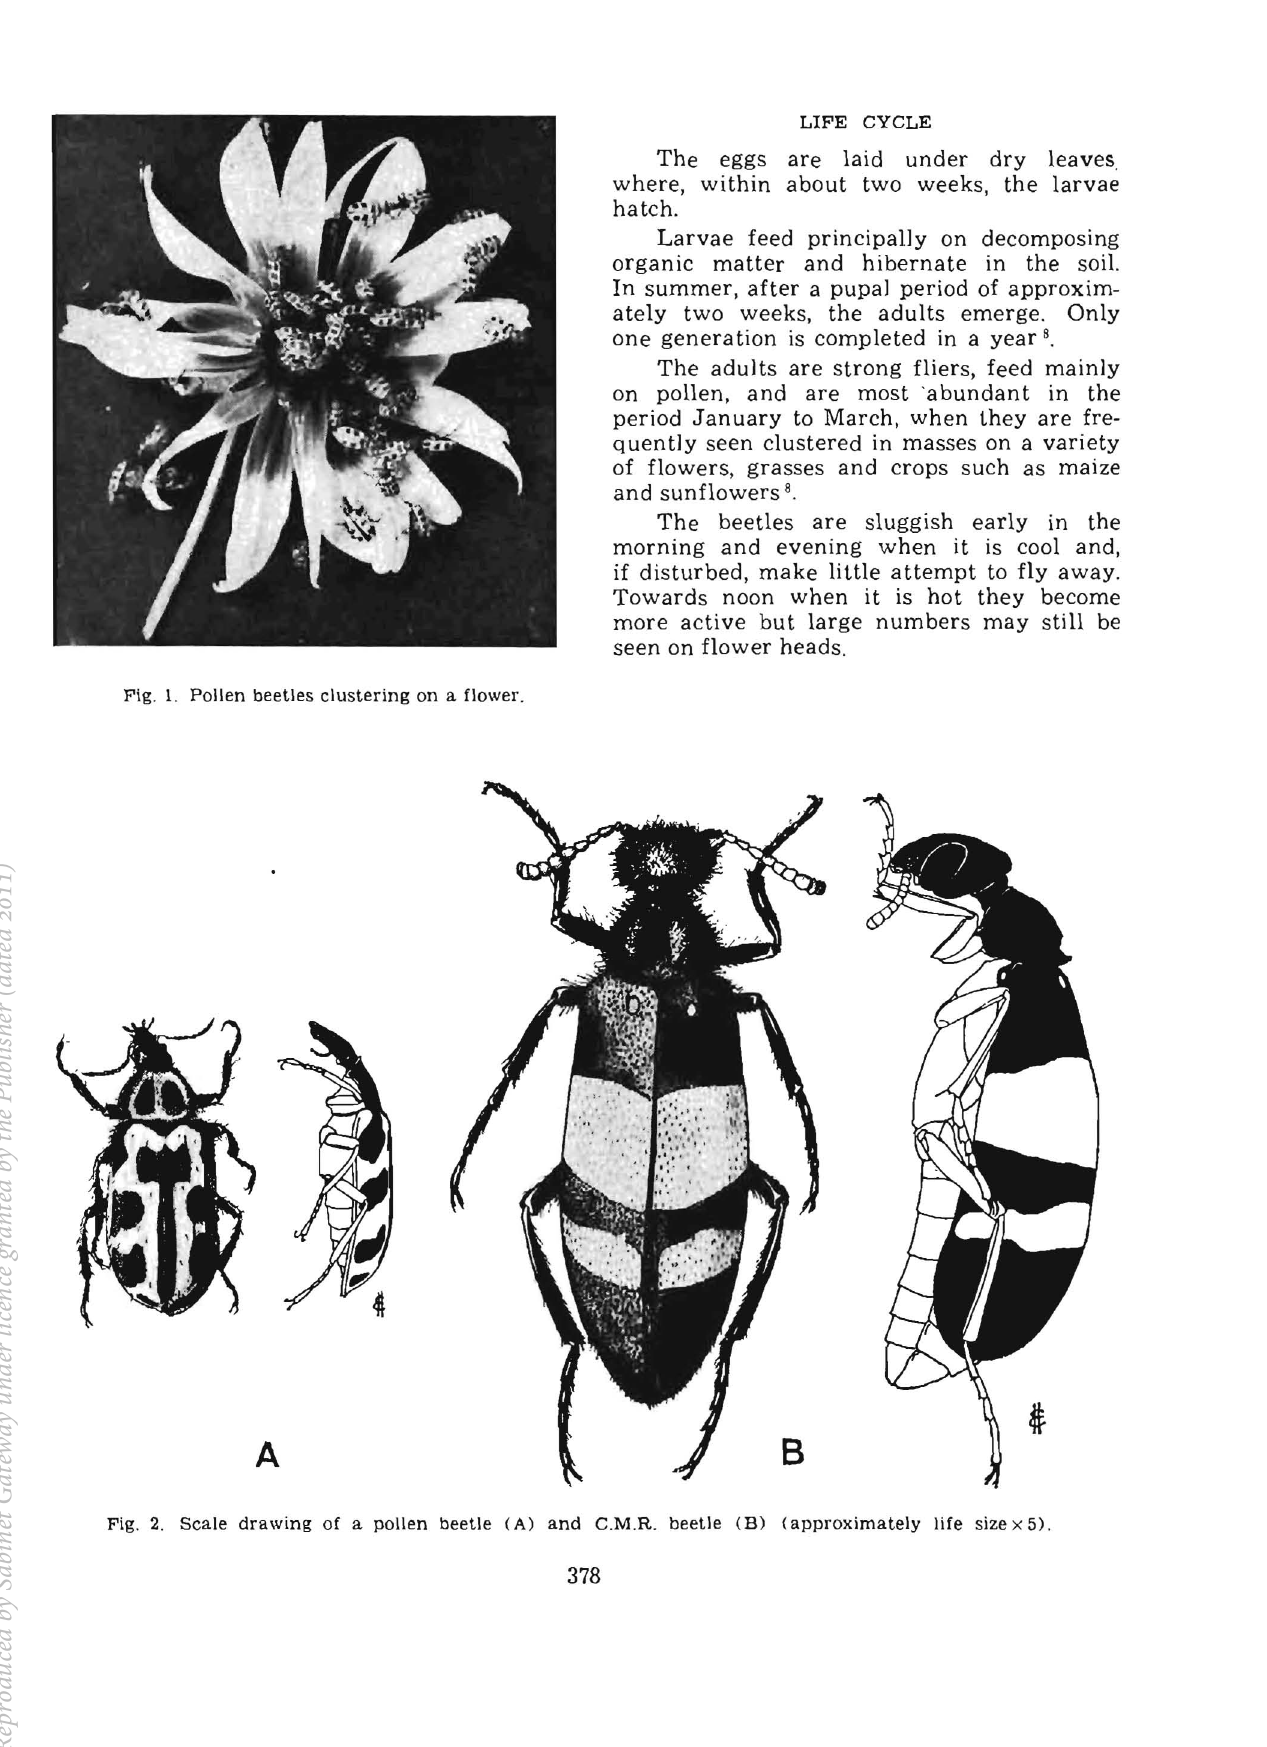
Fig.!. Pollen beetles clustering on a flower.